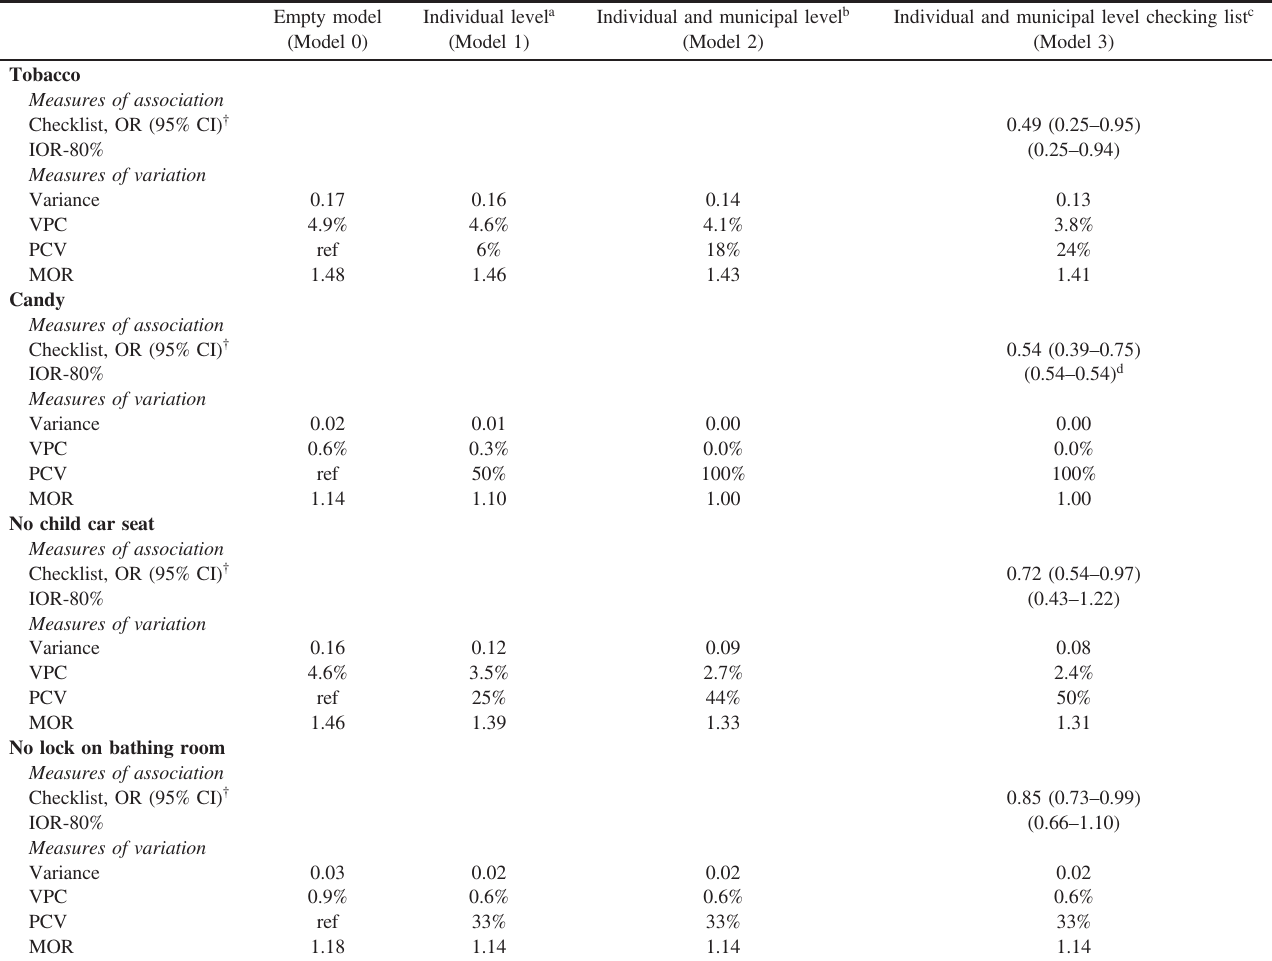
Table 3. Multilevel logistic regression analysis evaluating the relation between infant safety checklist and parental